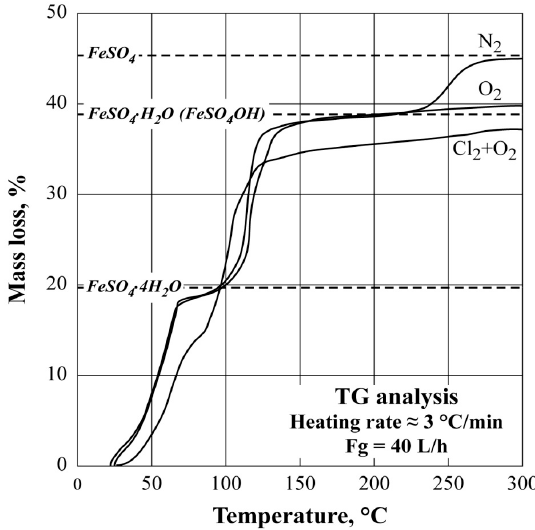
Figure 2. Thermogravimetric (TG) analysis of a FeSO 4 ∙ 7H 2 O sample under different atmospheres.